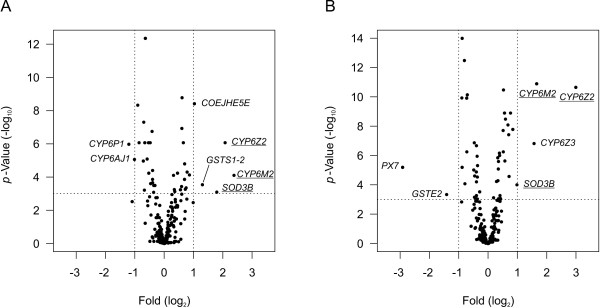
Microarray analysis comparing the permethrin resistant Odumasy strain with the standard susceptible Kisumu strain. Data are shown for the differences in expression levels between the permethrin resistant Odumasy strain and the standard susceptible Kisumu strain for both females (A) and males (B). Each dot represents the mean estimates, fold (M) and p-value (adjusted for multiple testing), for one gene from the complete microarray experiment. Names are shown for genes that are at least two-fold differentially expressed. Underlined names show genes that are common to both the female-female and male-male comparison. Horizontal line represents the level of significance α = 0.001, and vertical lines indicate two-fold change threshold.